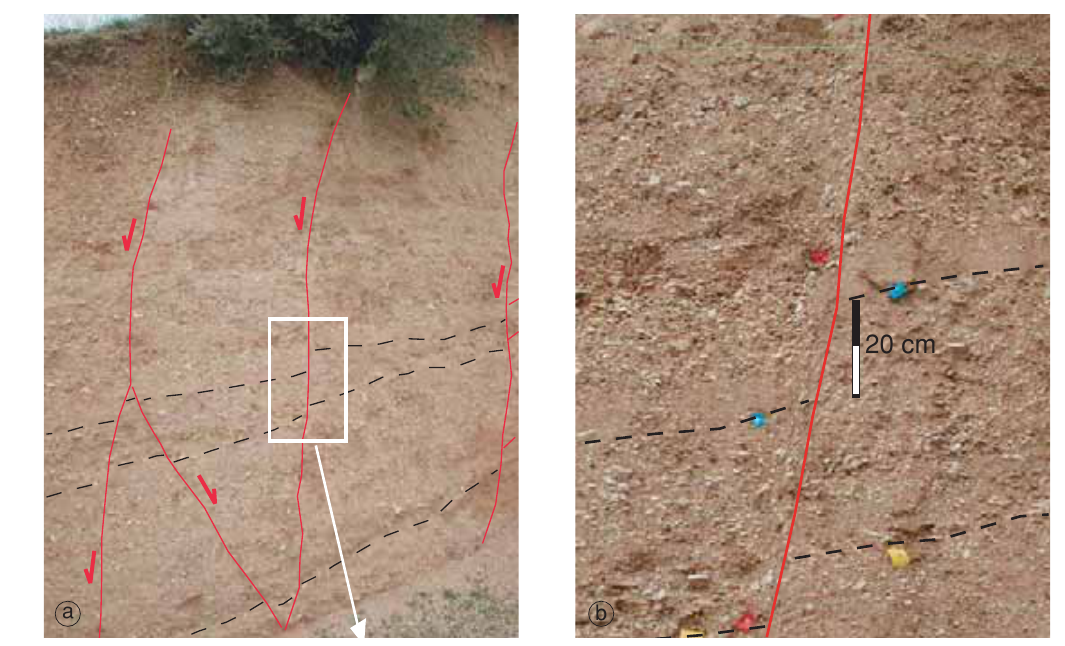
Fig. 14a,b. a) Photo of the NW wall of the artificial cut affecting the slope debris near the Gubbio Fault. In fig- ure are highlighted normal faults (continuous line) and main depositional horizon (dot line); b) detail showing the re-oriented clasts and the offset